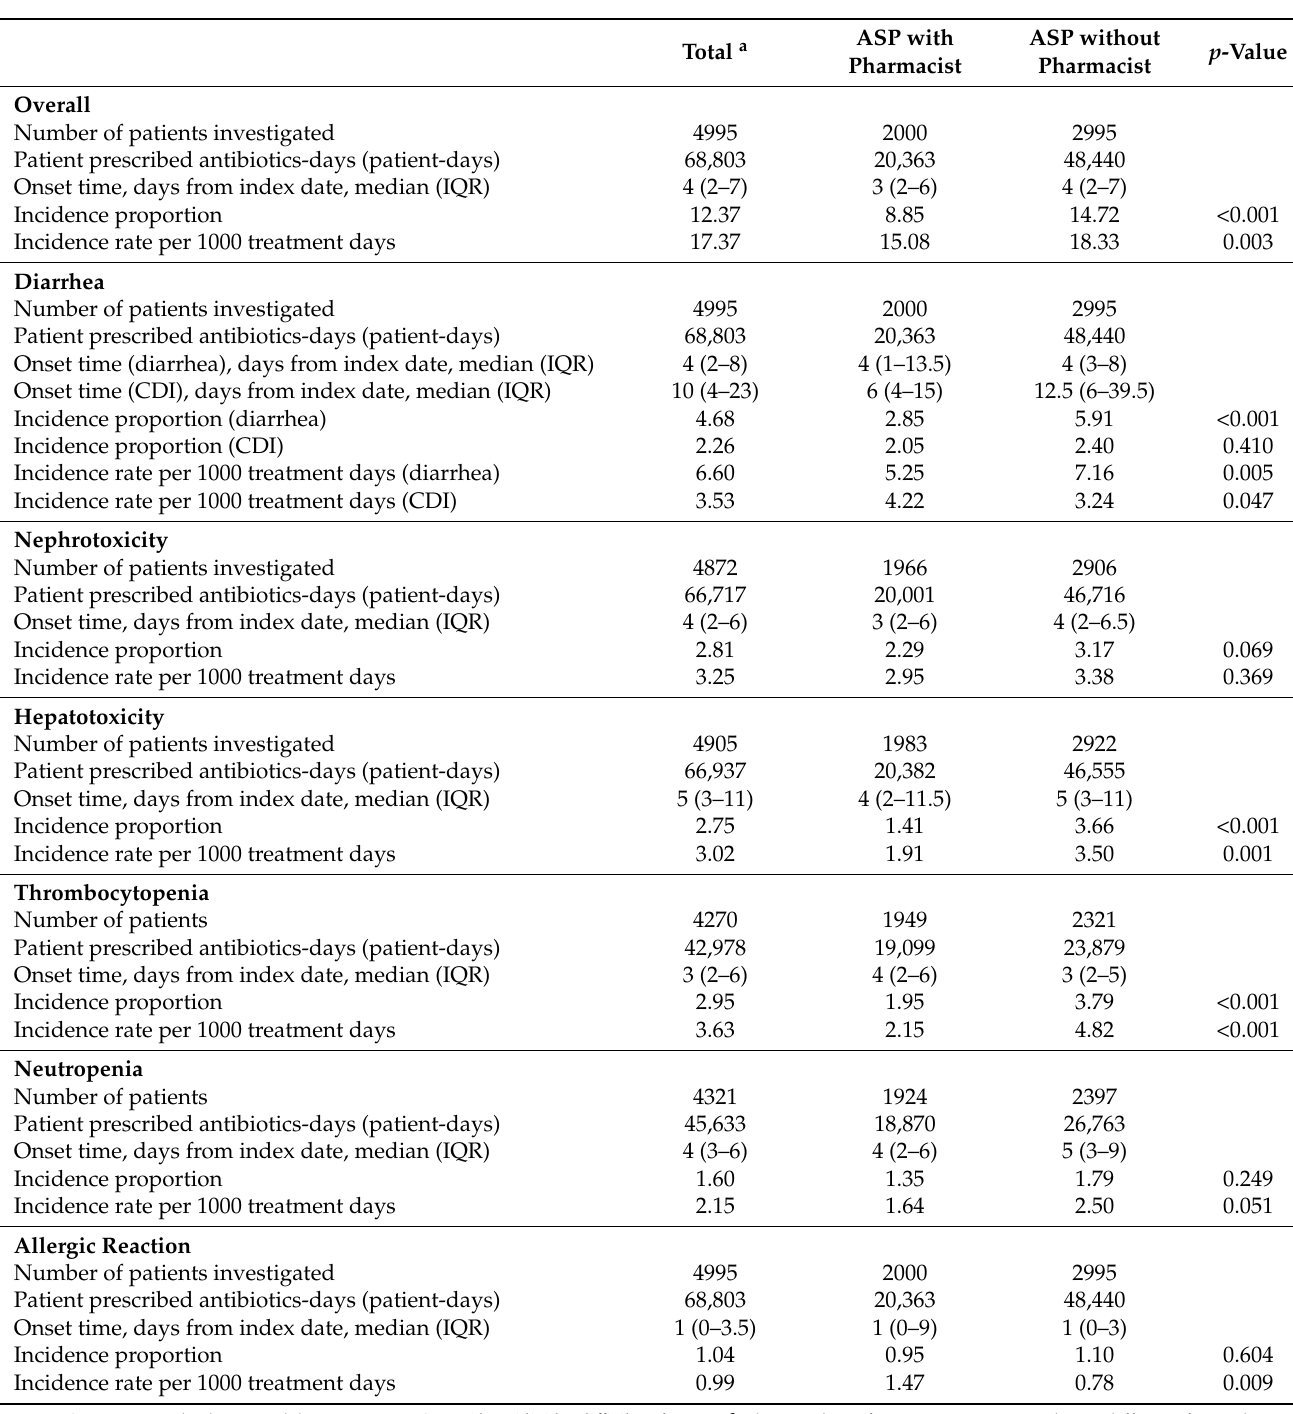
Table 2. Incidence rate by type of adverse events and type of antimicrobial stewardship